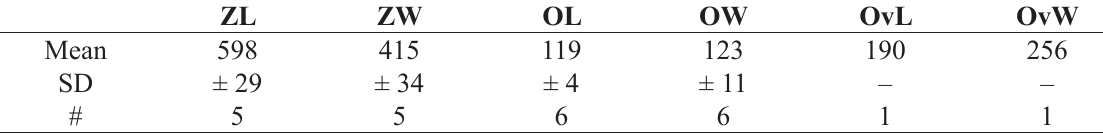
Table 10. Measurements of Atlantisina acantha gen. et sp.